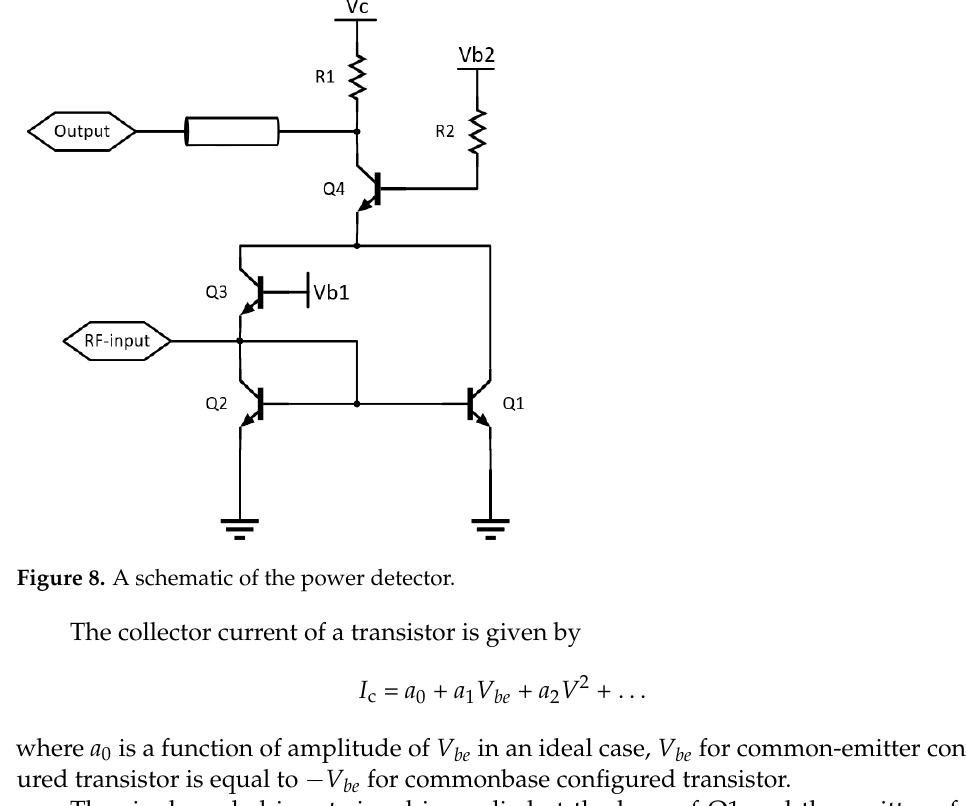
Figure 9. A photo of the fabricated power detector. The chip size including pads is 700 µm by 400 µm.